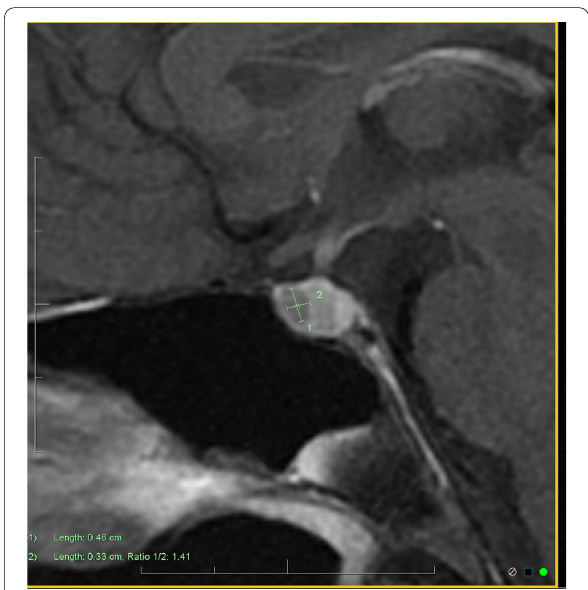
Fig. 1 MRI T1-weighted sagittal view of non-enhancing 0.46 0.33 cm focus of low signal in the left central portion of the × pituitary gland on the